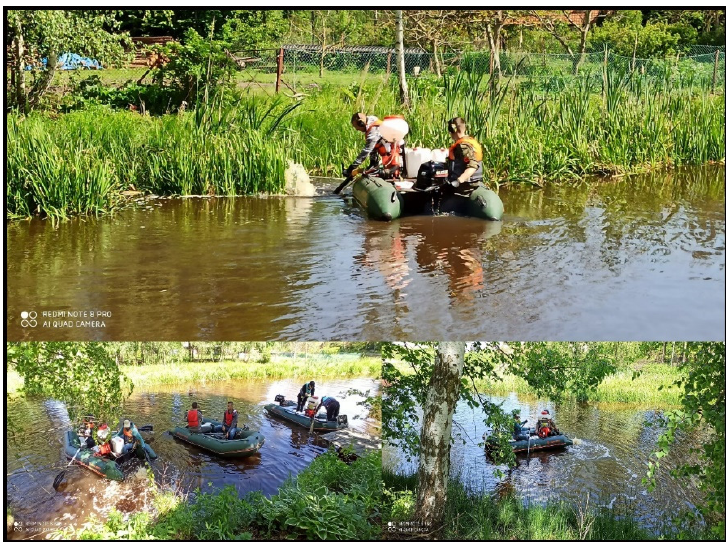
Figure 2. Biopreparation application into the water and bottom sediments by liquid injectors (tailored for these purposes).